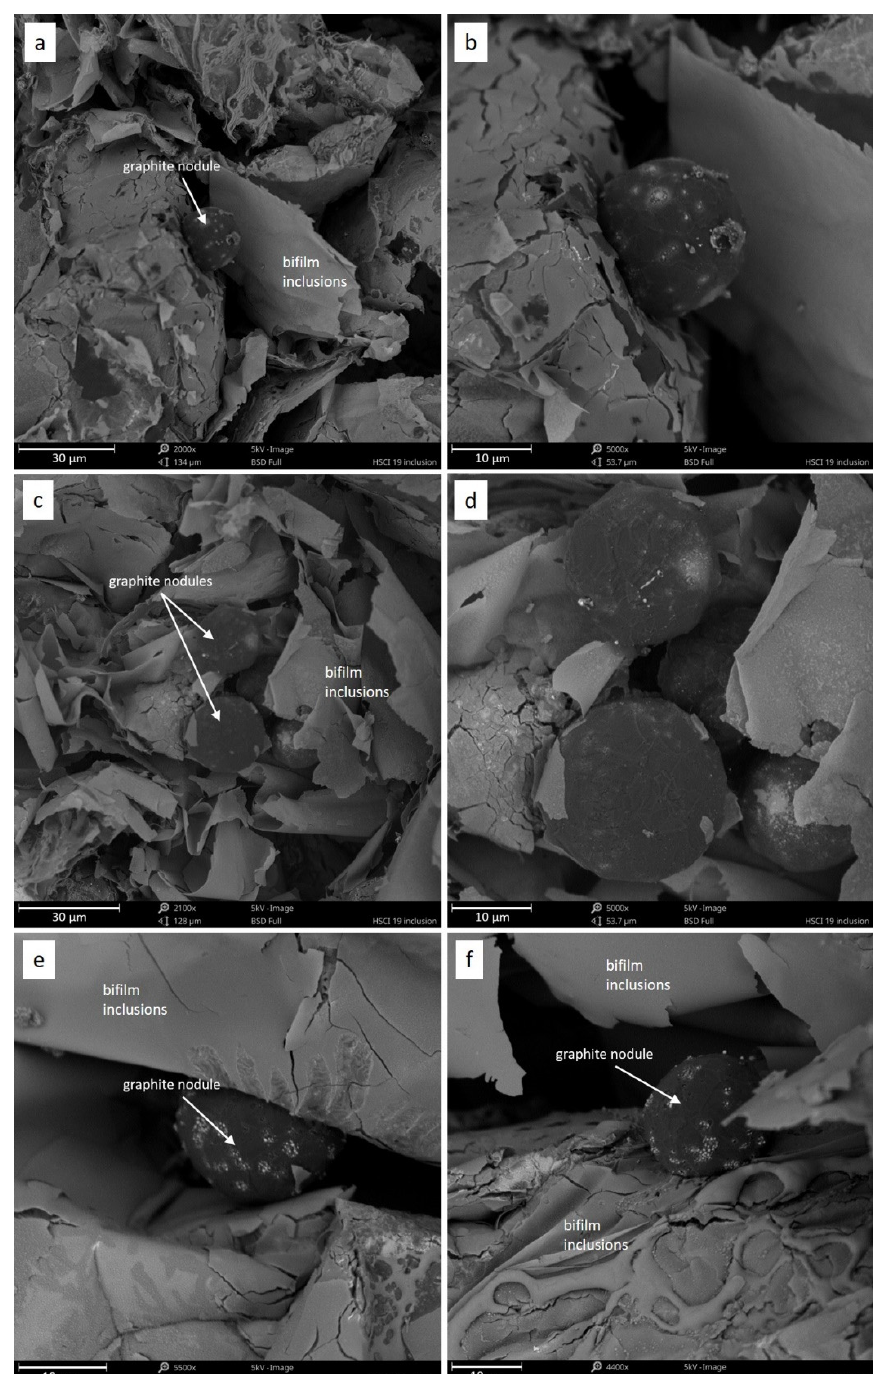
Figure 3. Contraction cavities ( a–f ) filled with bifilms inclusions and nodule graphite precipitates.